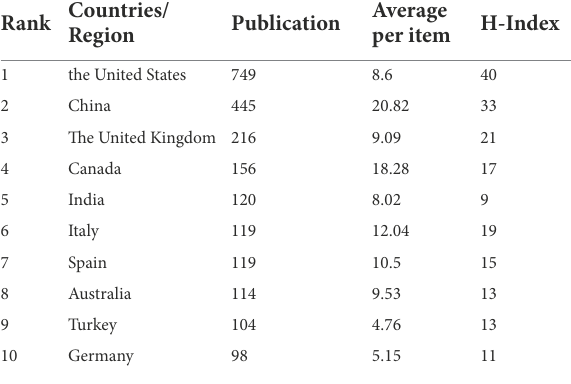
TABLE 2 The top 10 productive countries/regions related to mental health in students under COVID-19. Countries/ Rank